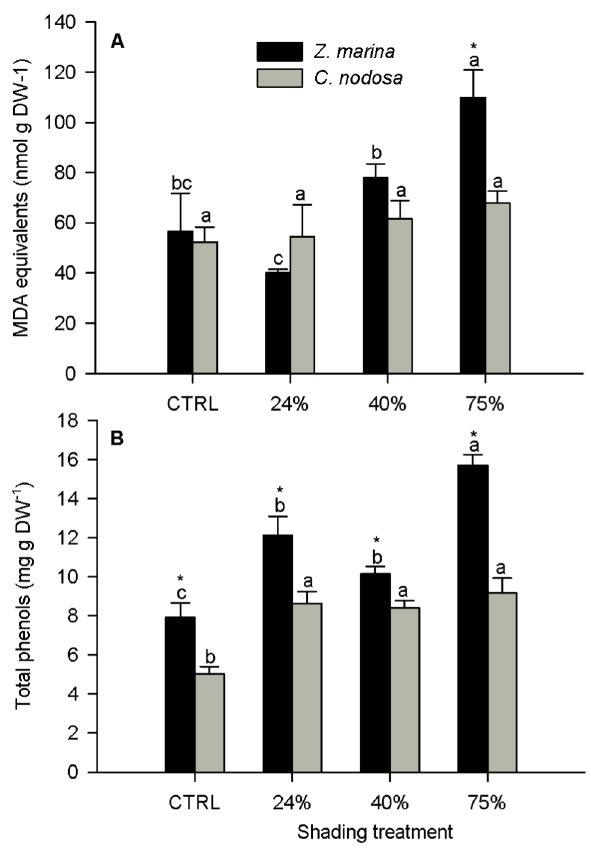
Figure 6. Malondialdehyde (MDA, A) and total phenols (B) in leaves of Zosteramarina and Cymodoceanodosa . Plants submitted to shading treatments of 24, 40 and 75% of naturally available photosynthetically active radiation (CTRL). Different letters indicate significant differences between treatments, * indicates differences between species (n=5, p ,